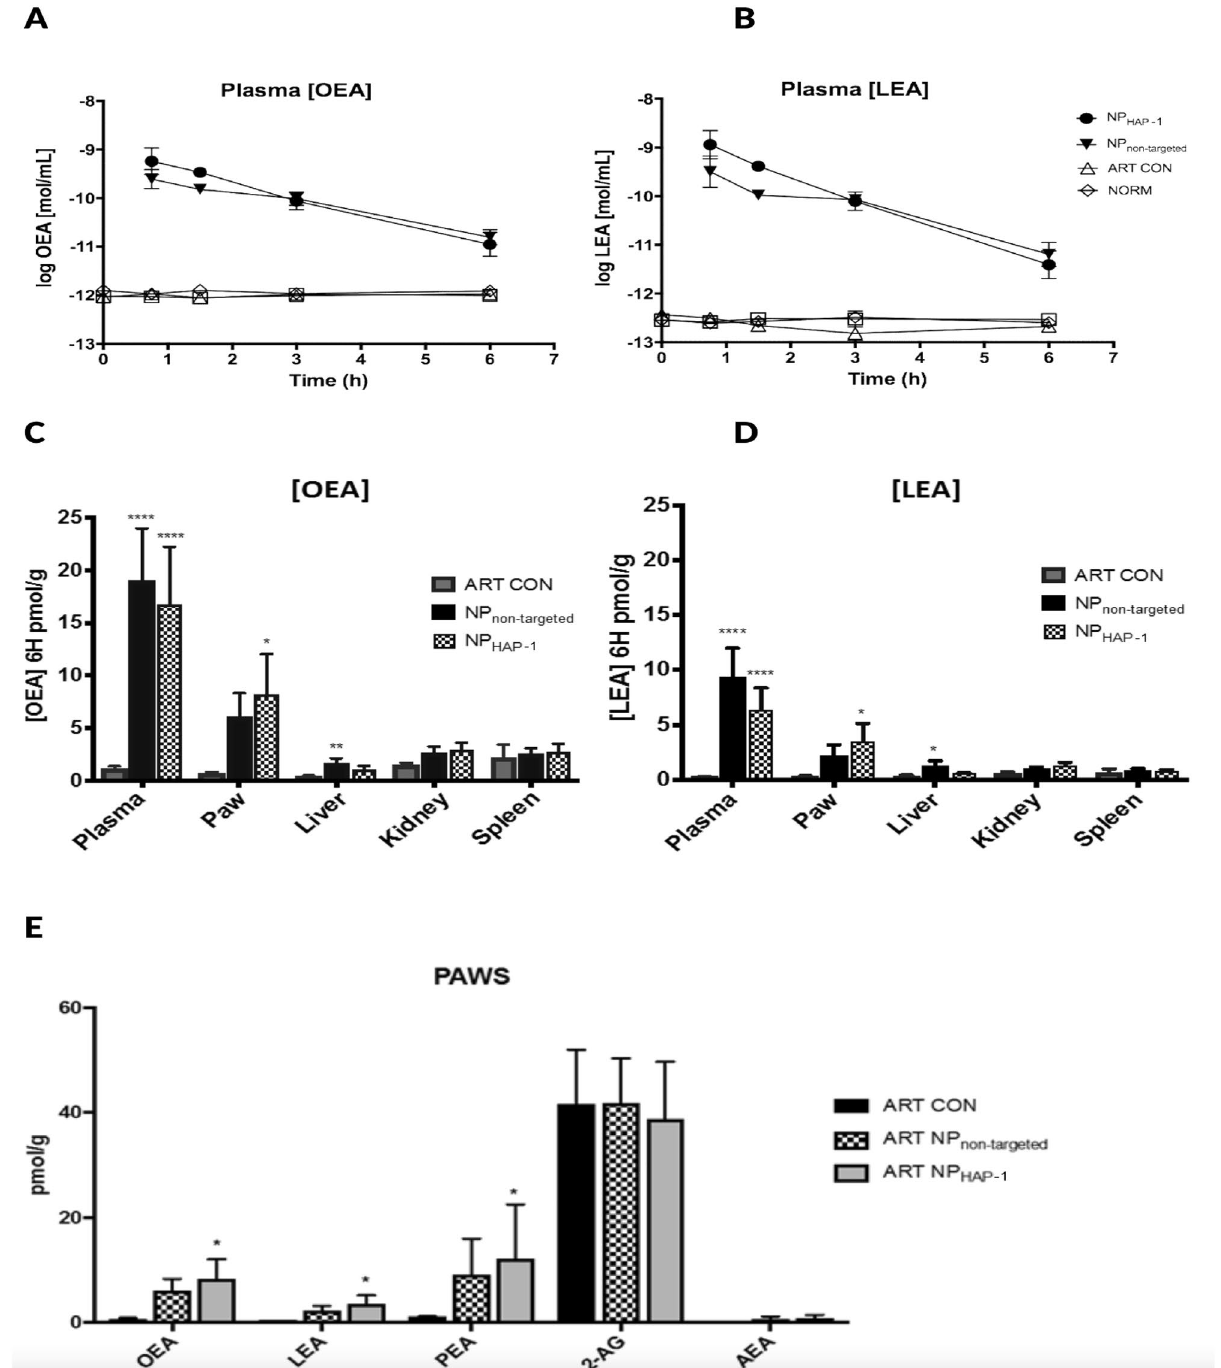
Figure 4. Plasma concentrations and biodistribution of OEA and LEA in normal rats (NORM), arthritic control rats (ART CON) and arthritic rats treated with NP non-targeted (ART NP non-targeted ) and NP HAP-1 (ART NP HAP-1 ). NPs were intravenously administered, and blood collected at 0, 45 min, 1.5, 3 and 6 h. After 6 h, organs and paws were harvested and analyzed on MS. Plasma concentration of; ( A ) OEA and ( B ) LEA concentration expressed as mol/mL (mean ± S.D., n = 5). Organ and paw concentrations of ( C ) OEA and ( D ) LEA expressed in pmol/g. (mean ± S.D., n = 5). *p < 0.05, ****p < 0.0001 vs ART-CON, Uncorrected Fisher’s least significance difference, two-way ANOVA. Significant accumulation to the paw was observed in NP HAP-1 treated rats. ( E ) Regulation of endogenous endocannabinoid OEA, LEA, PEA, 2-AG and AEA. Data expressed as pmol/g (mean ± S.D., n = 8). (*p < 0.05 vs ART CON, analysis using one-way ANOVA). Significant concentrations of OEA, LEA in ART NP HAP-1 were correlated to increases in